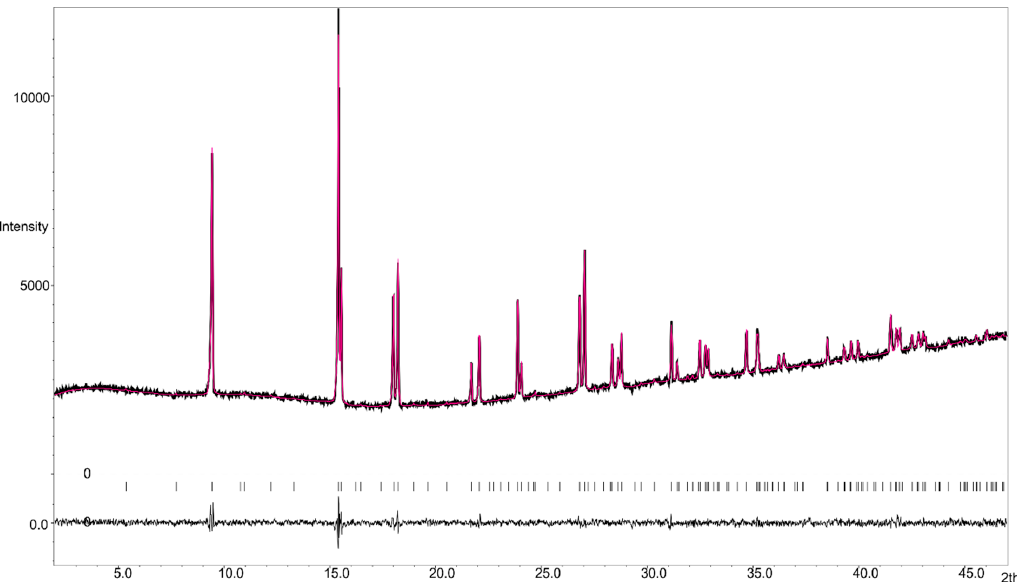
Figure 3. Fitted powder profile. Observed (black), fitted (pink), and difference profiles of tetragonal NaTl. (Mo radiation ( λ = 0.70926 Å (Mo-K α 1 )) yields a smaller 2 θ range compared to Cu radiation ( λ = 1.540598 Å (Cu-K α 1 )), which is typically used.) Table 2. Crystallographic data for tetragonal sodium thallide.